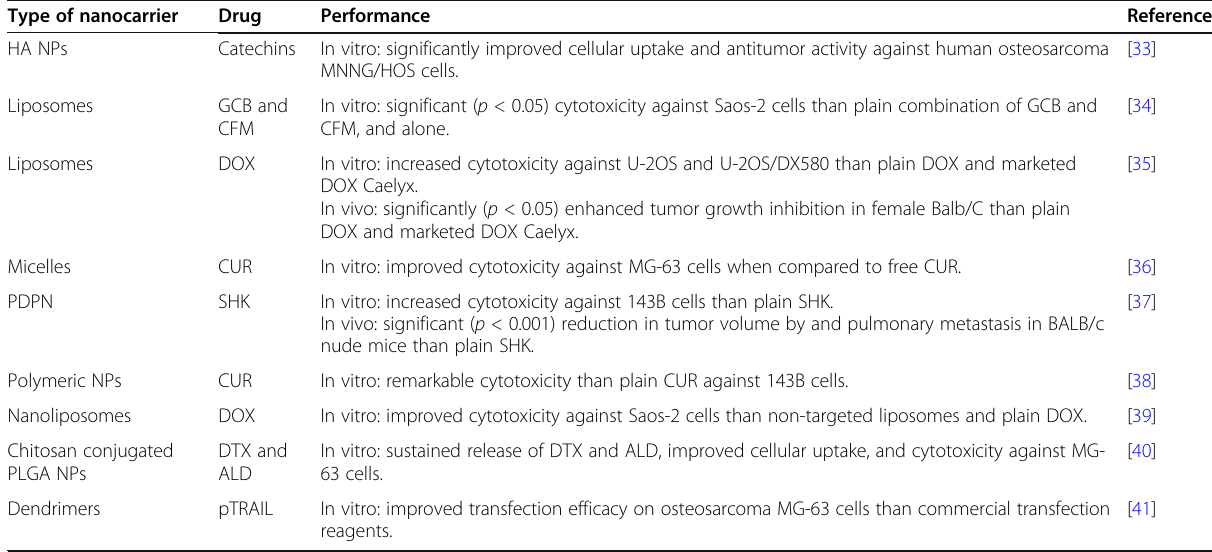
Table 1 Colloidal NPs tested for the treatment of osteosarcoma Type of